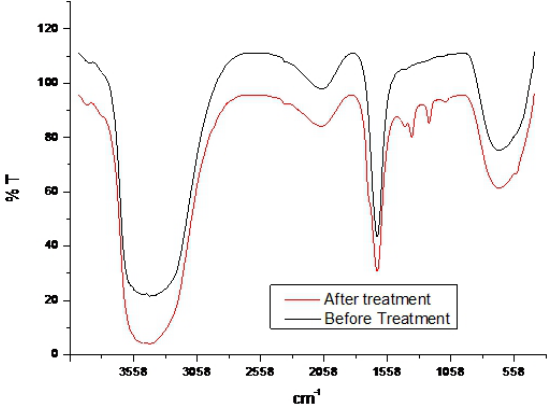
Figure 6. FTIR analysis of Decolorization of RB5 by Pseudomonas sp. before treatment (Black line) and its metabolites (Red